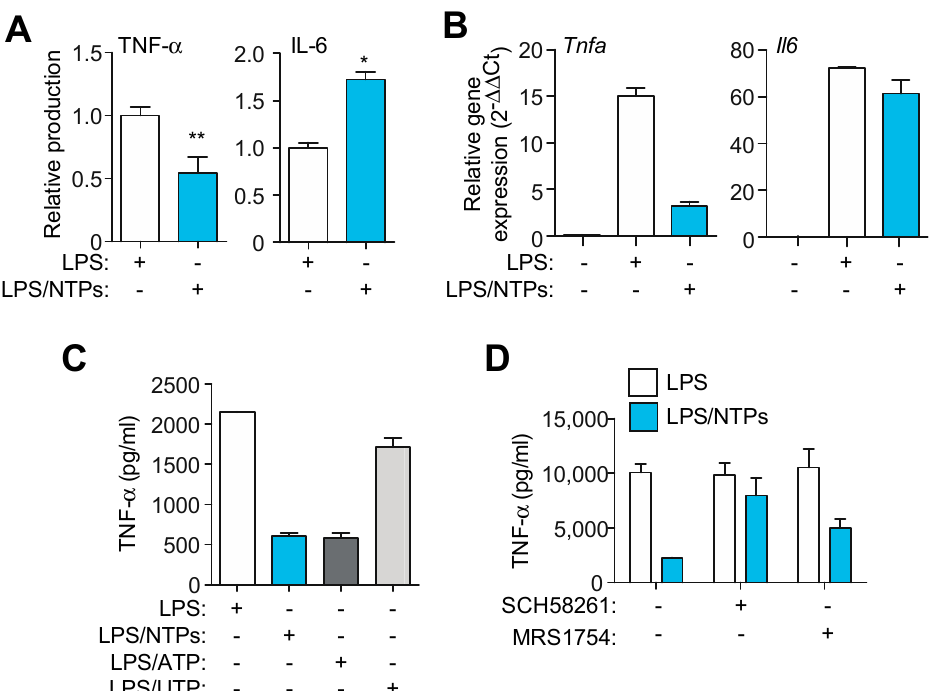
Figure 3. Nucleotides decrease TNF- α while increase IL-6 production. ( A ) ELISA for TNF- α and IL-6 in supernatants from peritoneal macrophages (RPMs) treated with LPS for 3 h in the presence (blue bars) or absence (white bars) of nucleotides (NTPs: 20 µ M UTP / ATP) without activating the NLRP3 inflammasome. Normalized data shows average + SEM from eleven (TNF- α ) and seven (IL-6) experiments. ( B ) qPCR analysis of TNF- α and IL-6 from RPMs treated as in (A); a representative experiment of three is shown + SD. ( C ) ELISA for TNF- α from cells treated as in (A), but combining nucleotides or separating them as indicated, one representative experiment out of three is shown + SD. ( D ) Supernatants from RPMs pretreated with the indicated inhibitors before being activated were analyzed for TNF- α ; a representative experiment out of two is shown + SD. * = p < 0.05 or ** = p < 0.01